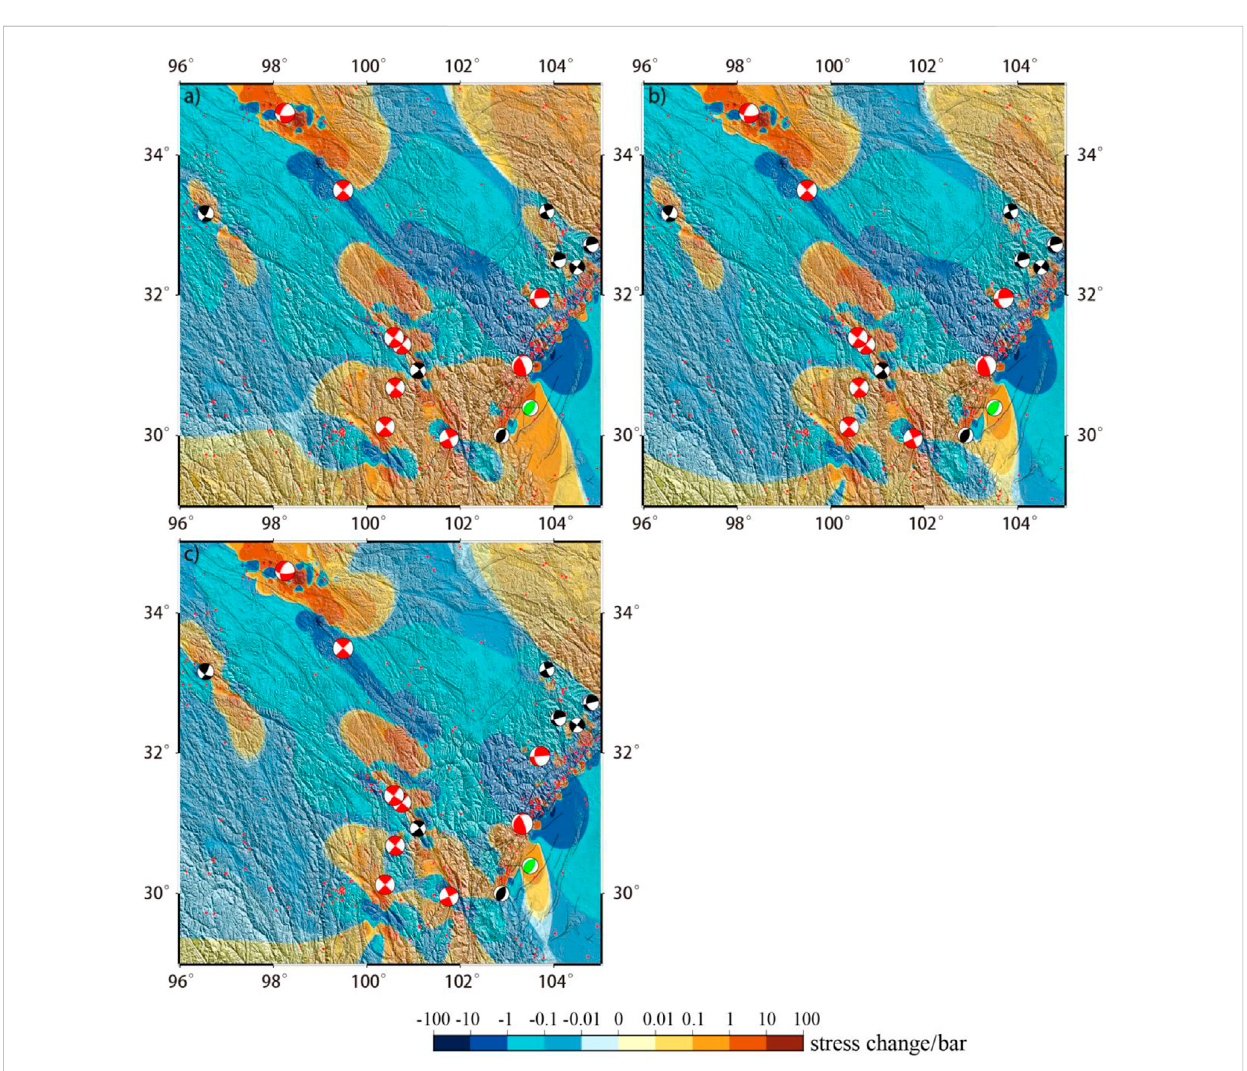
FIGURE 6 Impact of the viscosity coef fi cient, with low viscosity, normal viscosity, and high viscosity, on the Coulomb stress change contour map of the 2022 Lushan earthquake due to historical earthquakes. (A) Contour map of Coulomb stress change at low viscosity. (B) Contour map of Coulomb stress change at normal viscosity. (C) Contour map of Coulomb stress change at high